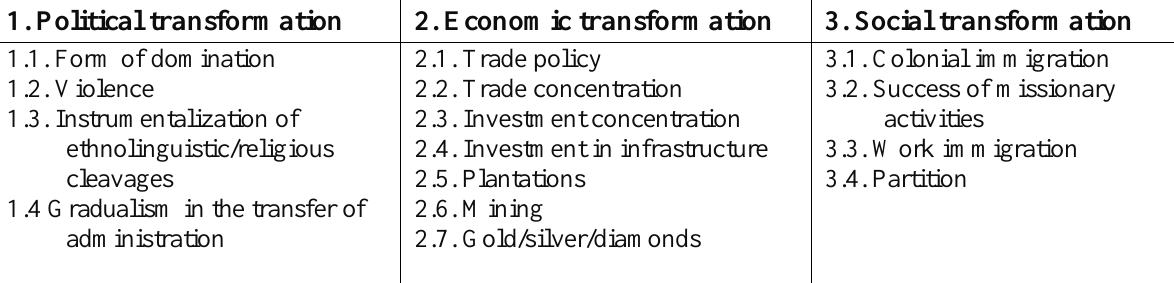
Table 1. Dimensions of colonial transformation